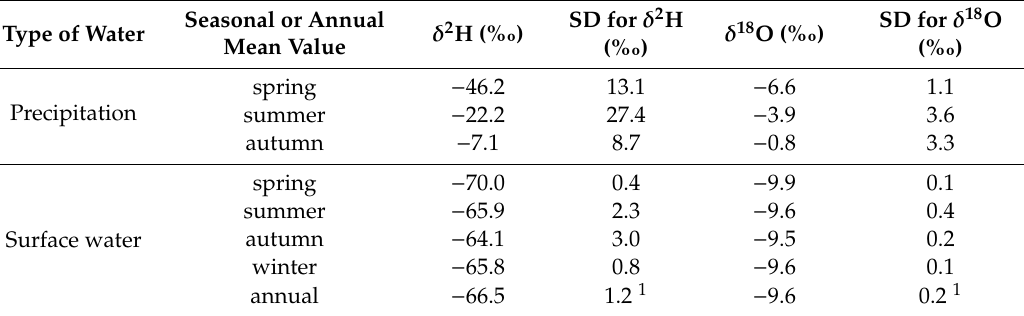
1 Annual standard deviations are calculated based on the 4 seasonal mean isotope